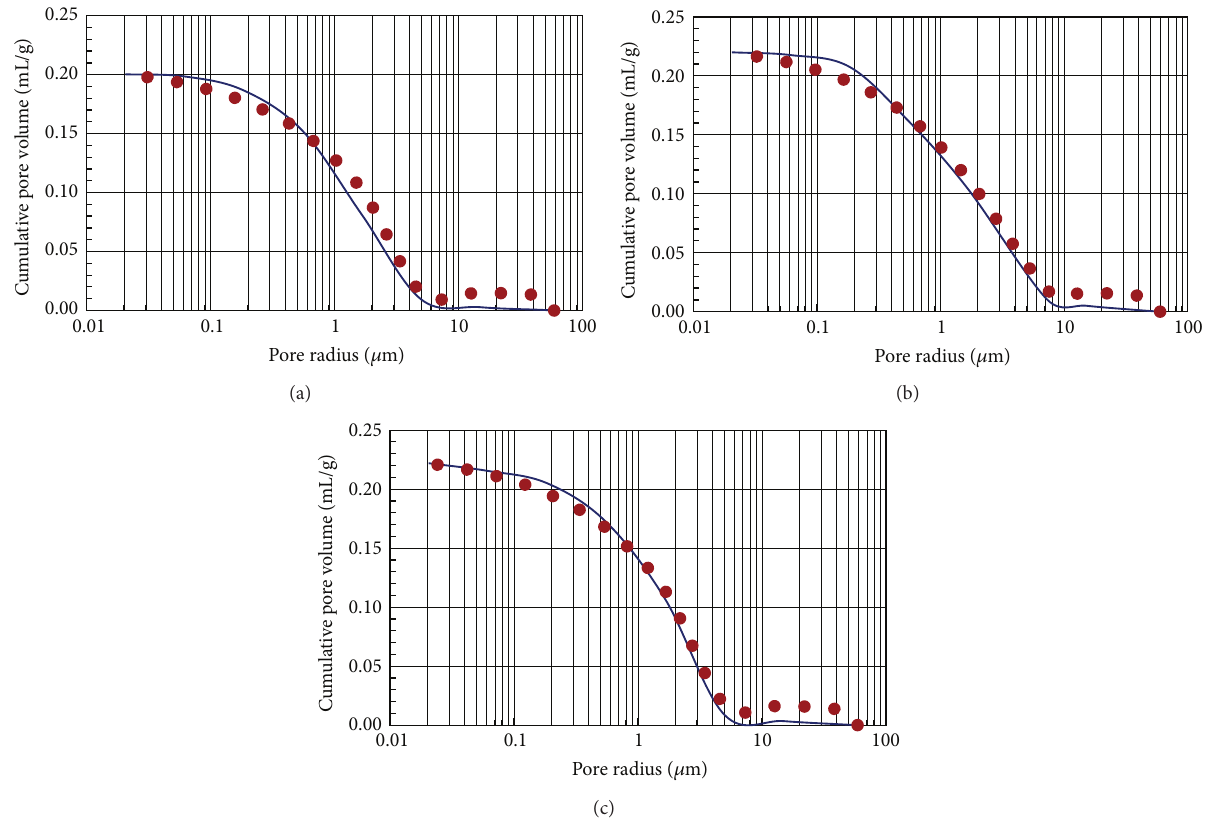
Figure 4: Comparison between experimental (continuous line) and IFU (dot line) pore cumulative curves A3 (a), B5 (b), and C2